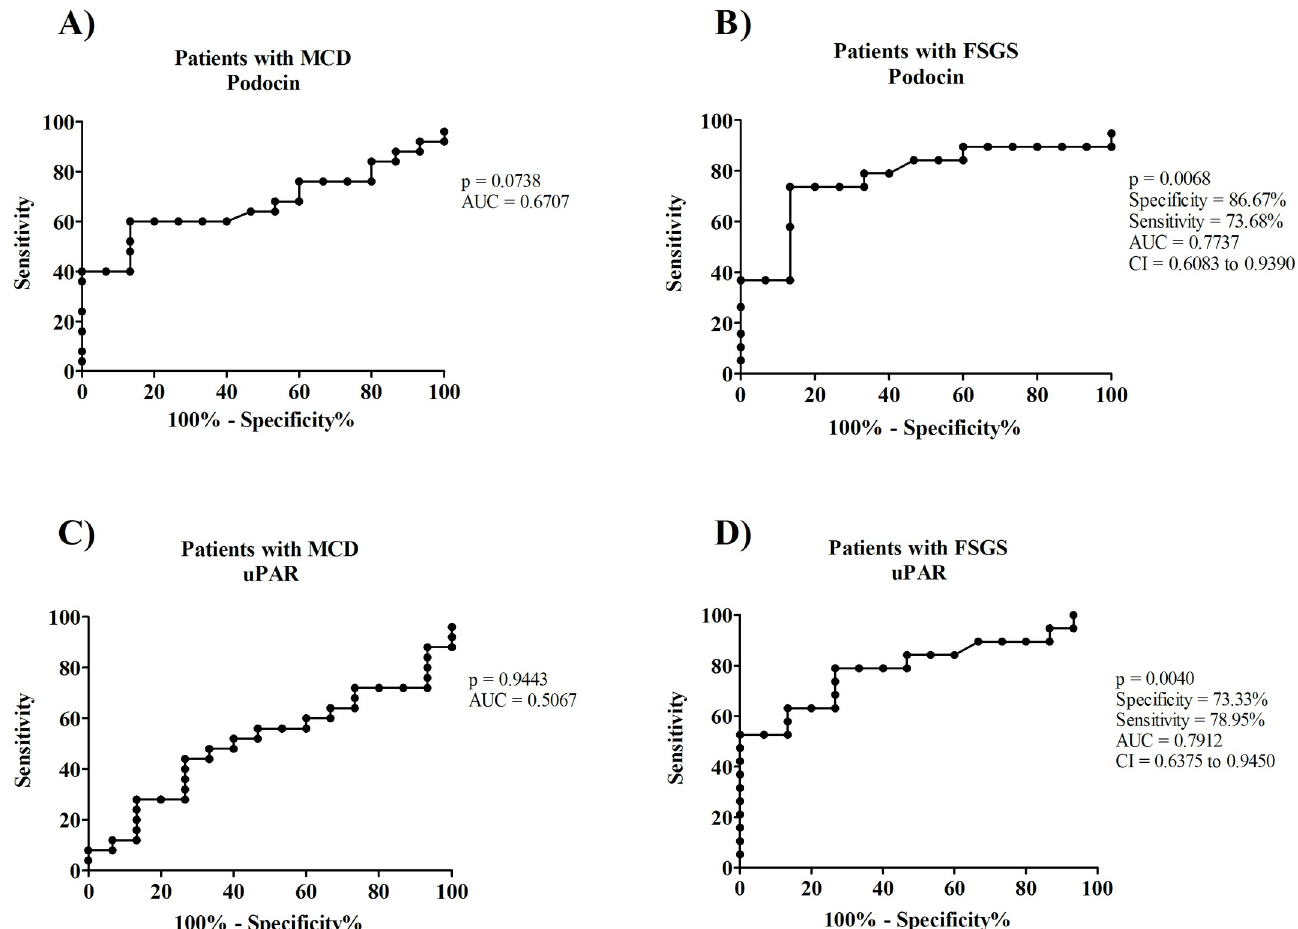
Fig 3. The receiver operating curves for models predicting podocin and uPAR performance for diagnosis of MCD and FSGS. (A) ROC curve graphic of plotted sensibility and 1-specificity of Podocin for MCD diagnosis. (B) ROC curve graphic of plotted sensibility and 1-specificity of Podocin for FSGS diagnosis. (C) ROC curve graphic of plotted sensibility and 1-specificity of uPAR for MCD diagnosis. (D) ROC curve graphic of plotted sensibility and 1-specificity of uPAR for FSGS diagnosis.